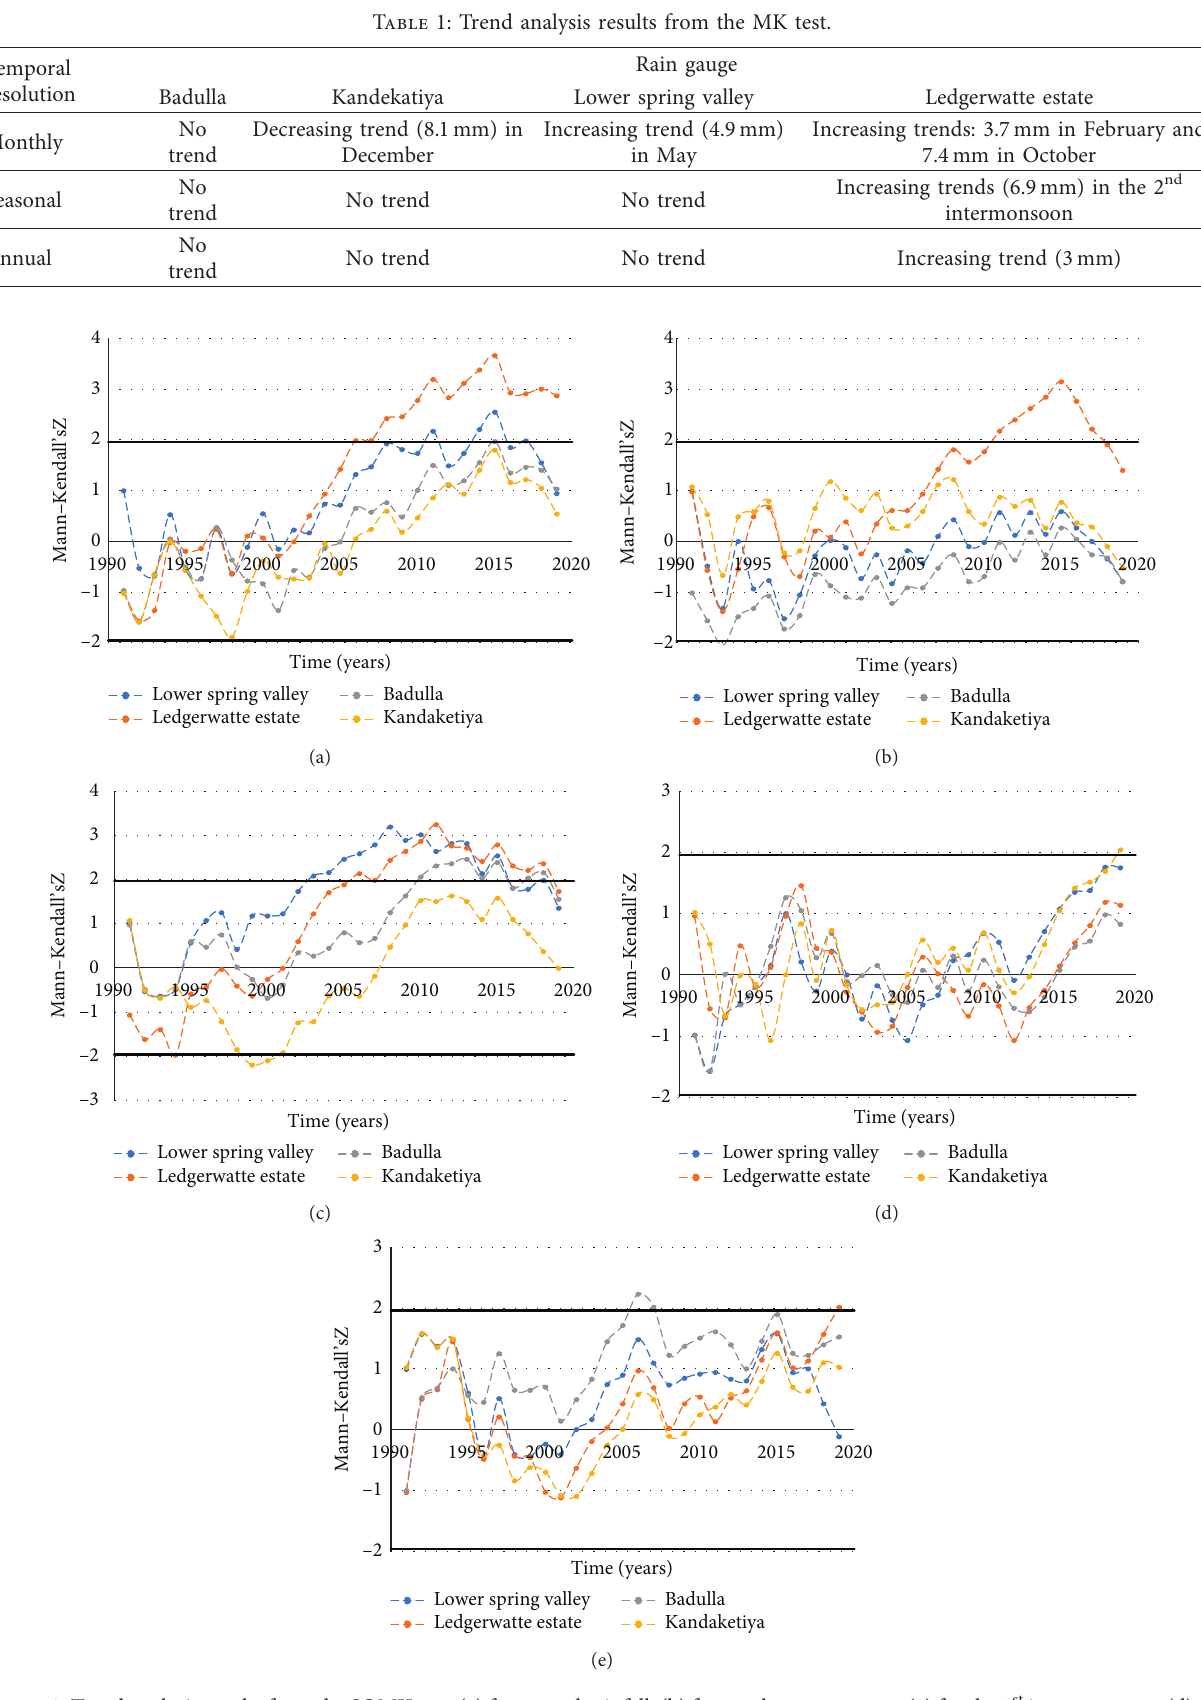
Figure 2: Trend analysis results from the SQMK test: (a) for annual rainfall; (b) for northeast monsoon; (c) for the 1 st intermonsoon; (d) for southwest monsoon; (e) for the 2 nd